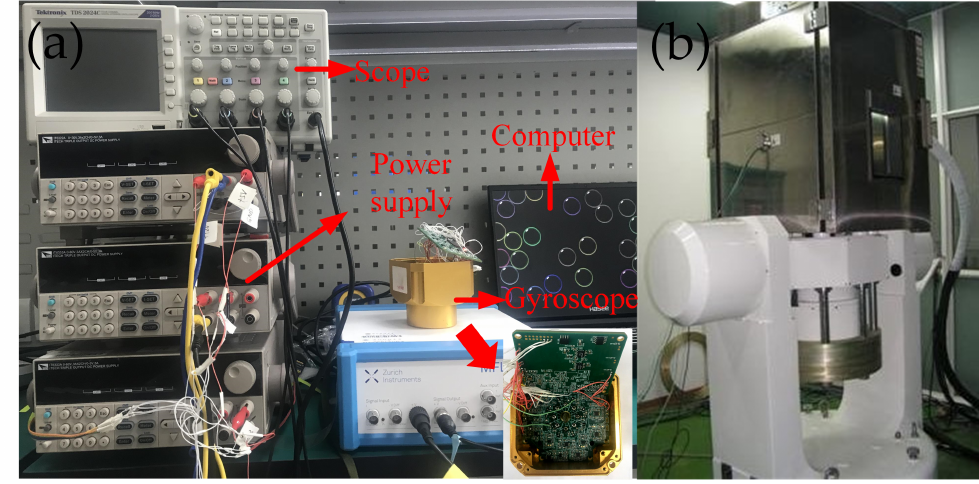
Figure 5. Experiment setup and the gyroscope for test.